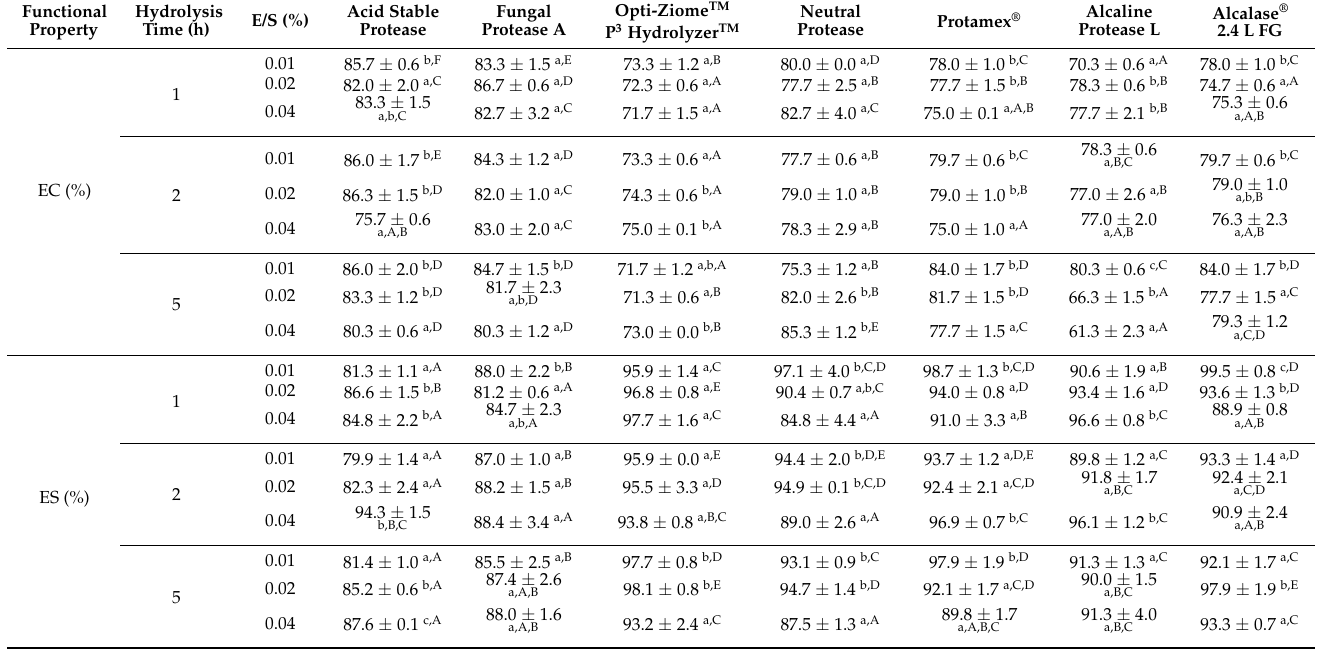
Table 3. Emulsifying properties of LPI hydrolyzed by different commercial